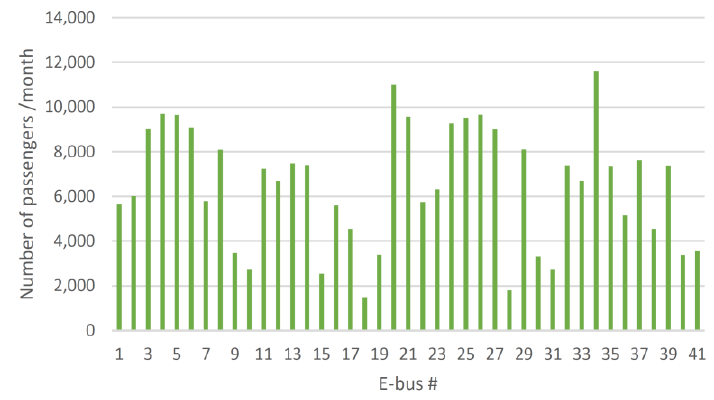
Figure 4. Number of passengers carried per month. Energies 2019 , 12 , x FOR PEER REVIEW